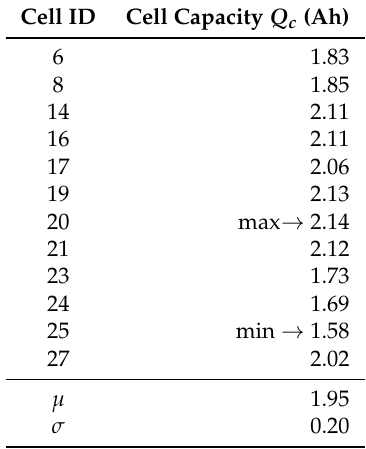
Table 1. Capacity of the recovered cells.